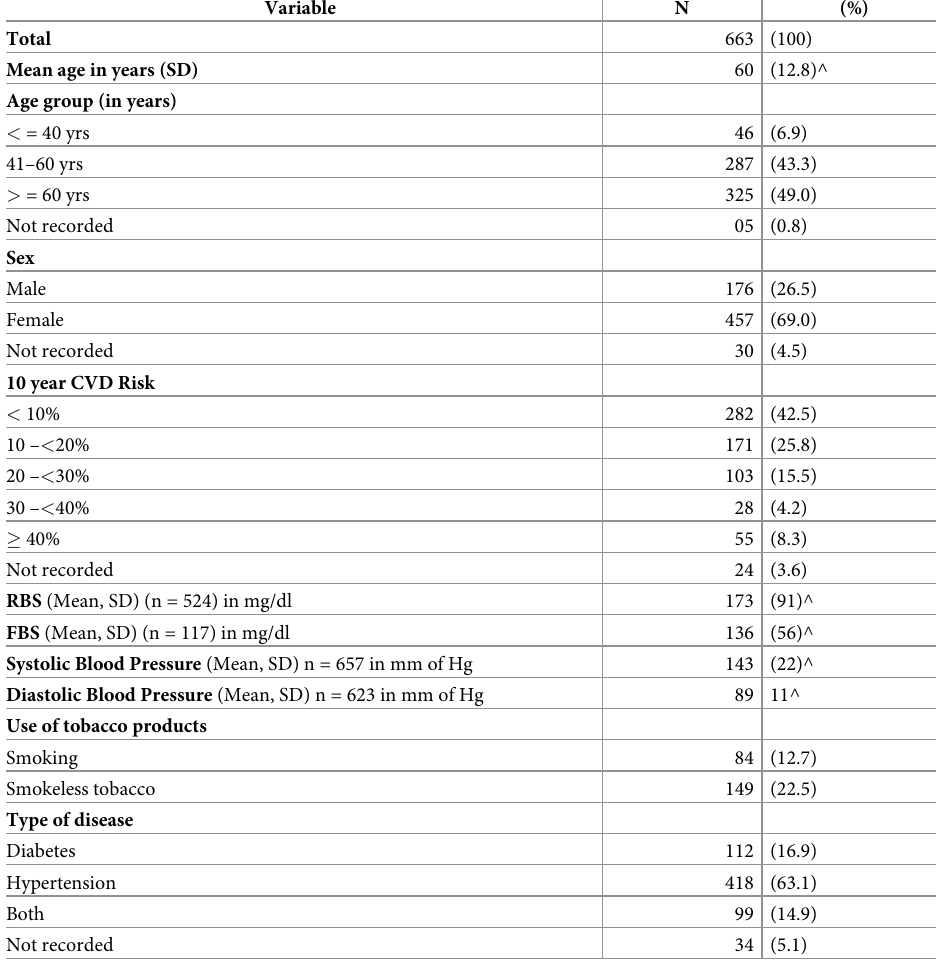
Table 2. Characteristics of patients diagnosed and registered with hypertension or diabetes or both in 5 selected townships implementing PEN project, Myanmar, between May- October 2017. Variable N